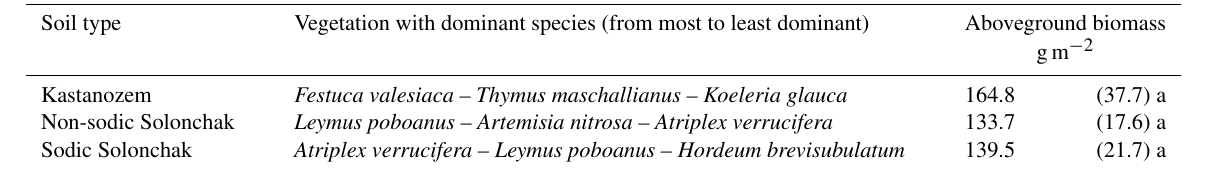
Figure 1. Schematic representation of study sites and the experimental design. The same colors of the soil profiles and plant samples mark the same soils. A detailed soil type classification of the grouped soils is given in Table S1. Table 1. Vegetation (dominant species) and aboveground biomass on each soil type. Given are the arithmetic means and the standard error of the mean in parentheses. Significant differences ( p < 0.05) were not present and are denoted as lowercase